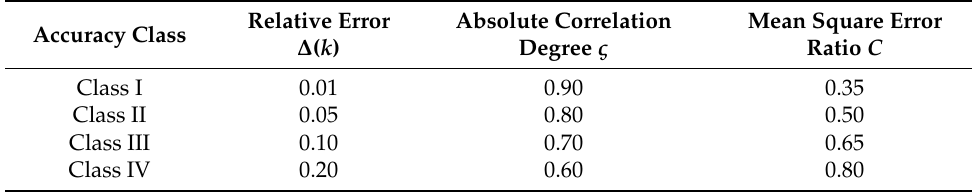
Table 1. The reference of model accuracy inspection grades.